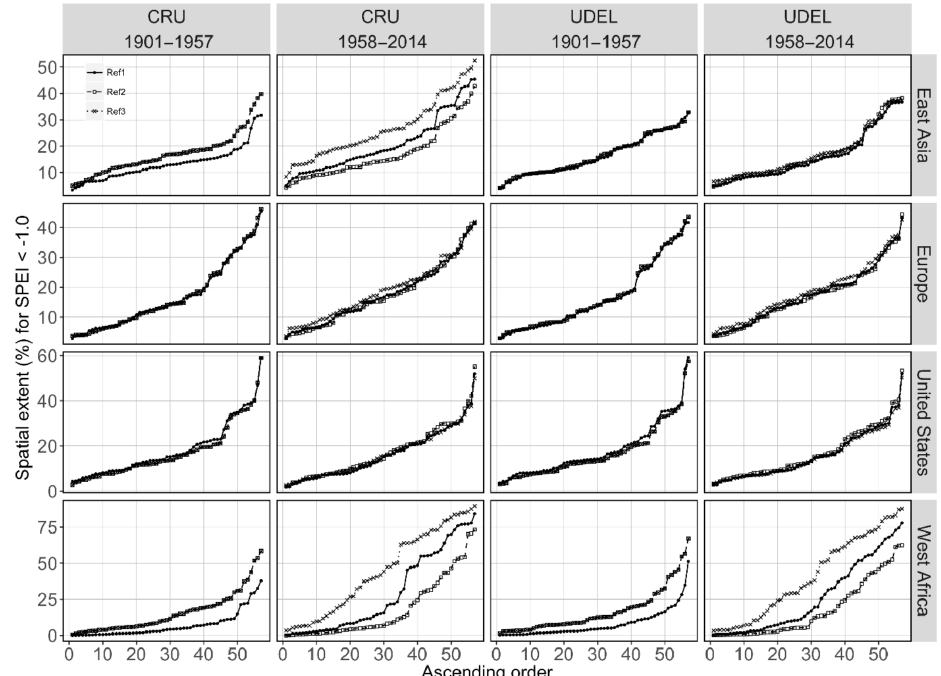
Figure 11. Spatial extent (%) of SPEI-12 < − 1 . 0 for three different reference periods (Ref1, Ref2 and Ref3 in Table 2) based on the CRU and UDEL datasets from 1901 to 1957 and 1958 to 2014 in each region. Table 5. Monthly average D (mmmonth − 1 ) in each region for the periods of 1901–1957 (P1), 1958–2014 (P2) and 1901–2014 (P1 + P2) based on the CRU and UDEL datasets. CRU UDEL P1 P2 P1 + P2 P1 P2 P1 + P2 East Asia − 4.29 − 5.85 − 5.07 − 3.40 − 5.03 − 4.21 Europe 7.32 7.21 7.26 5.92 5.91 5.92 United States − 1.09 0.64 − 0.23 − 0.75 1.13 0.19 West Africa − 99.26 −